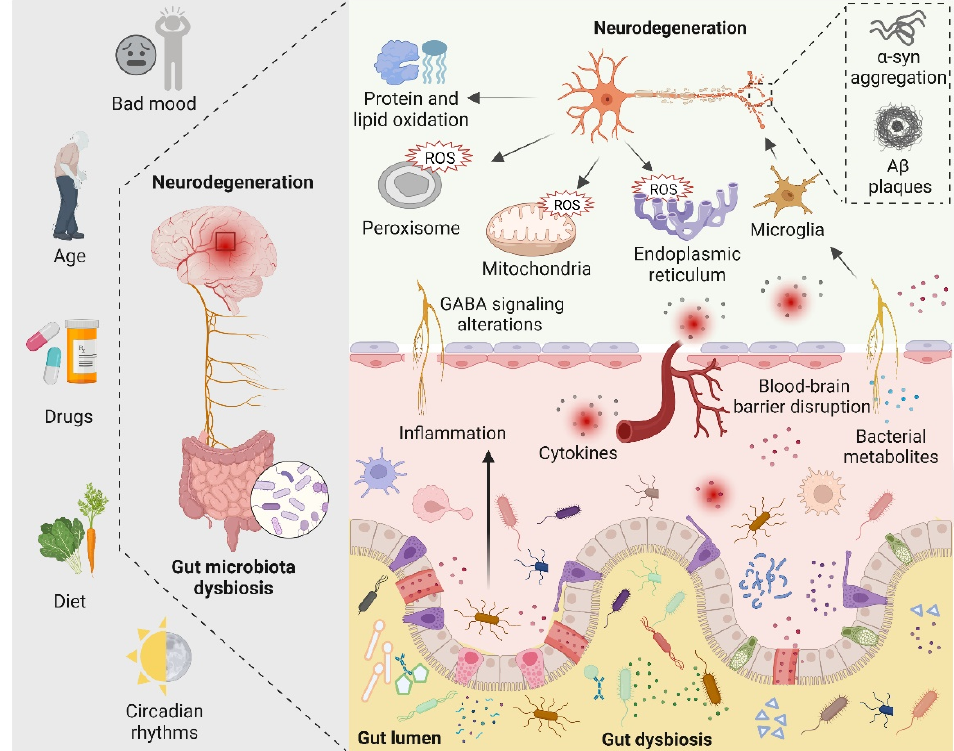
Figure 3. The role of the gut microbiota in neurodegeneration is depicted schematically. Bad mood, increasing age, drugs, dietary changes, and circadian rhythms can disrupt gut microbiota home- ostasis. When gut dysbiosis occurs, beneficial bacteria in the gut are transformed into pathogenic bacteria, producing a large number of harmful metabolites and proinflammatory molecules, resulting in increased blood–brain barrier permeability and peripheral inflammatory responses, thereby ag- gravating oxidative stress in the brain. At the same time, dysbiosis can induce bad mood. Increased levels of ROS in neuronal mitochondria, endoplasmic reticulum, and peroxisomes, increased protein and lipid oxidation, and accumulation of neurotoxic proteins lead to